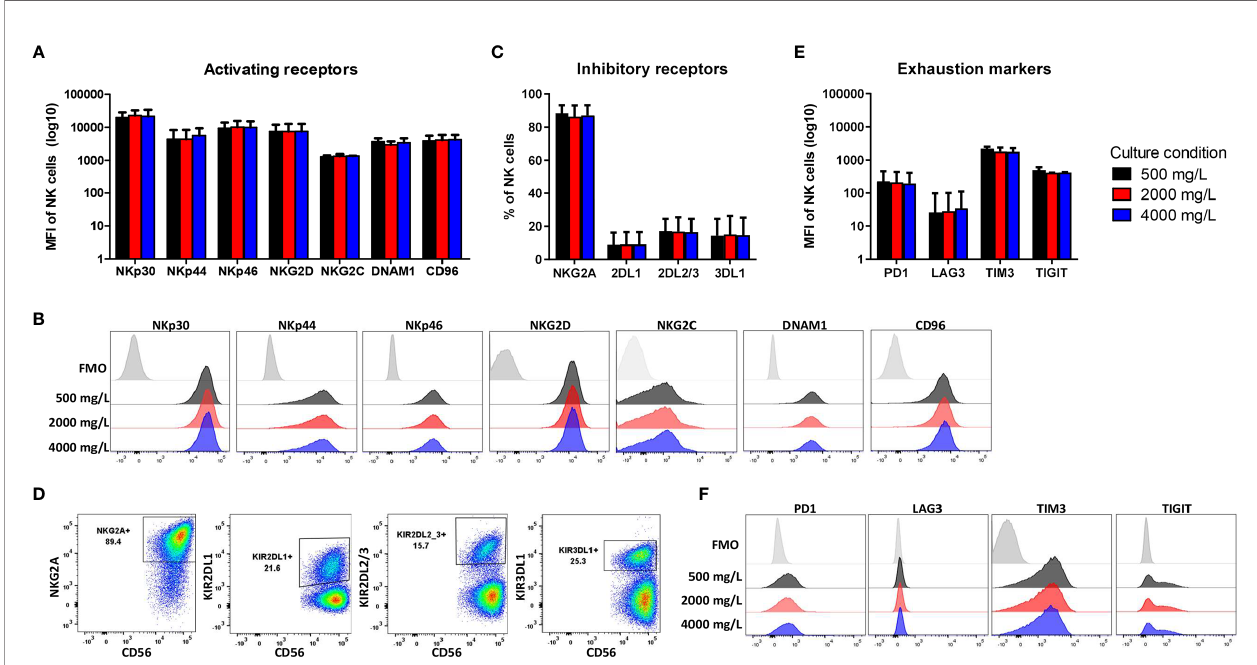
FIGURE 4 | Phenotype pro fi le of expanded NK cells is not altered by long-term exposure to low or high glucose levels. NK cells were expanded with 2000 mg/L glucose and subsequently cultured in different glucose concentrations for 4 days (culture condition). NK cells were stained with antibodies against activating receptors (A, B) , inhibitory receptors (C, D) and exhaustion markers (E, F) and analyzed by fl ow cytometry. Bar graphs (A, C, E) depict the average expression of n=2 donors for NKG2C, TIM3, TIGIT and n=5 donors for all other markers, error bars indicate SD. FMO values were subtracted from MFI expression values. Representative histograms (B, F) or dot plots (D) of one donor are shown with the FMO of one of the three glucose concentrations as FMOs overlapped tightly ( Supplementary Figure S3